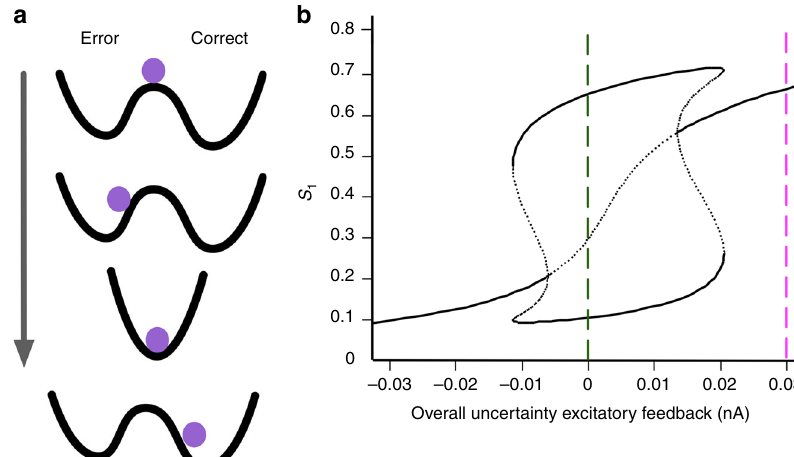
Fig. 6 Uncertainty-induced, symmetric stable steady state causes change-of-mind. a Top-to-bottom: Hypothetical “ potential well ” of network changes over epochs within a trial (arrow). When making a choice between two alternatives, the strength of the stimulus (and noise) drives the ball towards one of the two wells (in this case, an error choice). A transient strong excitatory input (due to excitatory feedback from uncertainty-monitoring module) changes the “ energy ” landscape into one centralized deep well, allowing a higher chance to change its initial decision. b Bifurcation (or stability) diagram of the activity of a neuronal population selective to choice 1/Left in the sensorimotor module, S 1 , with respect to variation in the overall excitatory feedback input current from the uncertainty-monitoring module. Evidence quality ε = 0. Black bold: stable steady states; black dotted: unstable saddle steady states. Dashed green: initial low uncertainty-induced excitatory feedback and lying within the winner-take-all regime. Dashed magenta: intermediate epoch of a trial with large uncertainty-induced excitatory feedback — only one stable steady state exists. Later epoch of a trial reverts back to green dashed